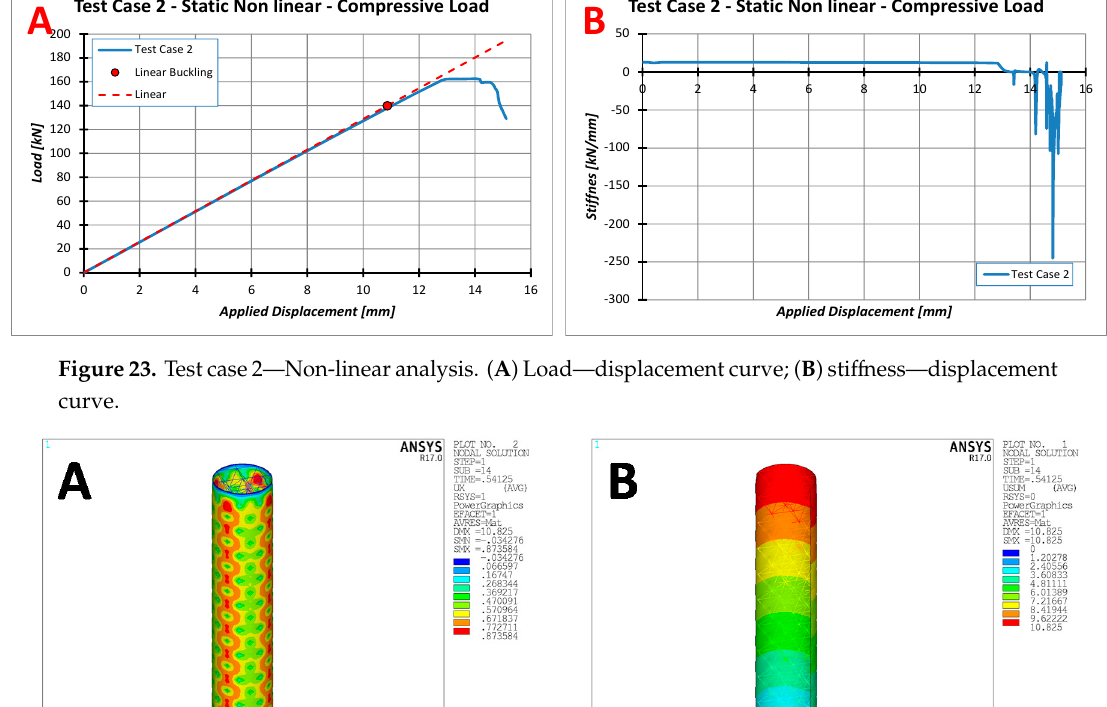
Figure 23. Test case 2—Non-linear analysis. ( A ) Load—displacement curve; ( B ) stiffness— displacement curve.